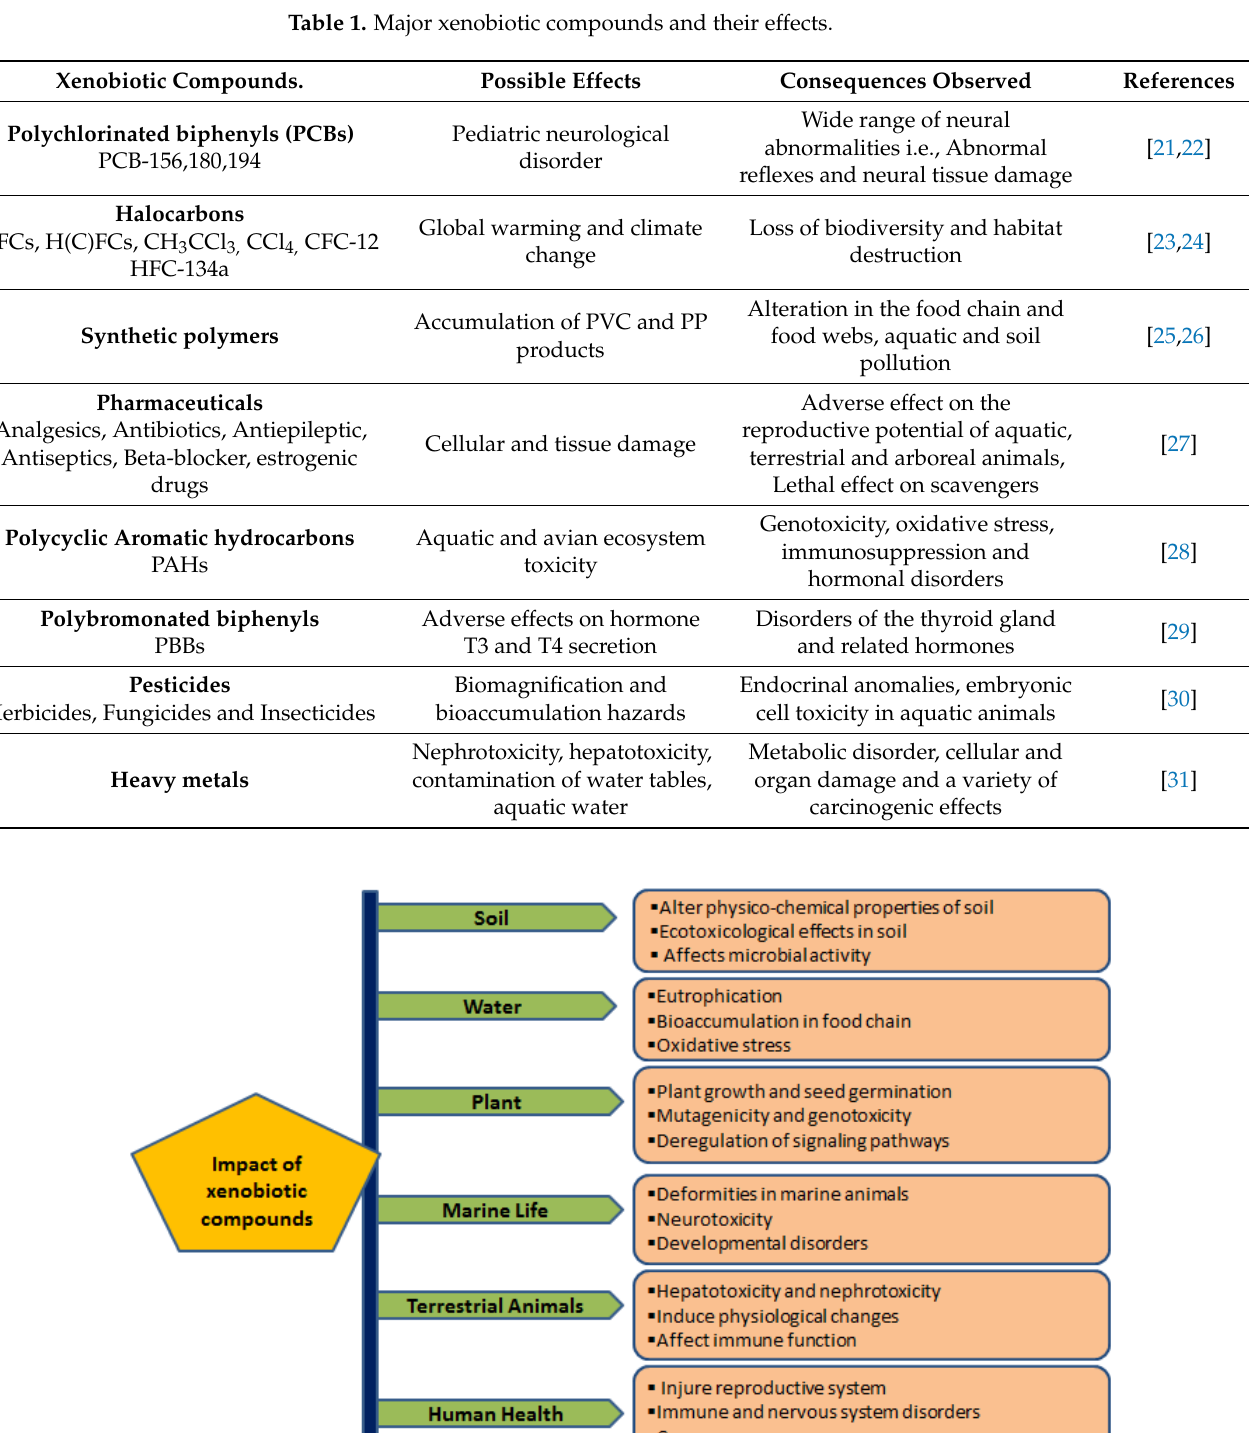
Table 1. Major xenobiotic compounds and their effects.